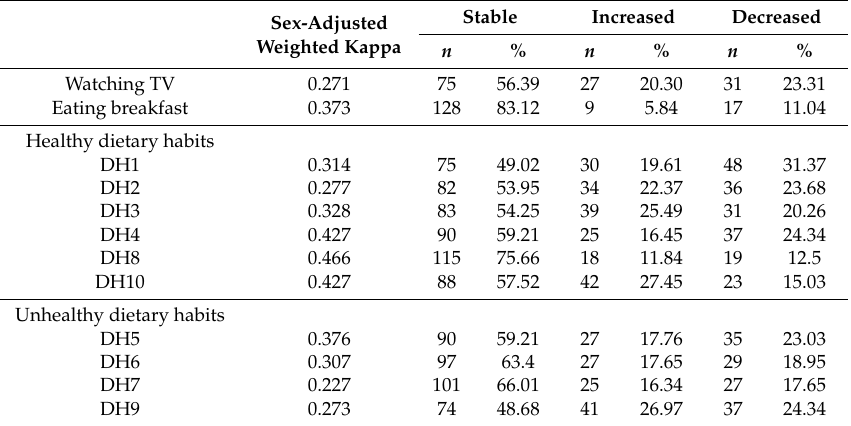
Table 4. Changes in individual’s behaviors over two years.